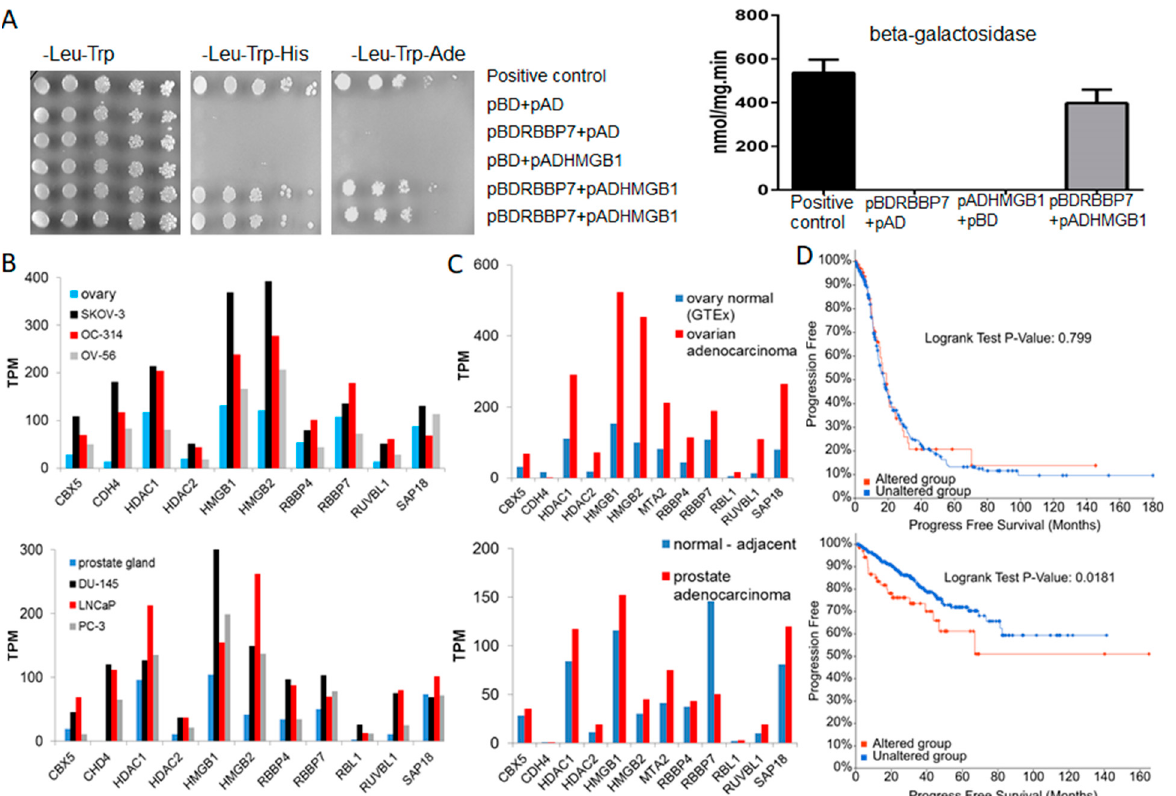
Figure 3. ( A ) Validation of the HMGB1 ‐ RBBP7 interaction by the two ‐ hybrid approach. ( B ) Differential mRNA levels of NuRD complex subunits in normal and cancerous ovary and prostate cell lines. ( C ) Differential mRNA levels of NuRD complex subunits in tumours and adjacent normal tissue in patients diagnosed of ovary and prostate cancers. ( D ) Analysis of disease ‐ free progression in patients with mRNA levels of NuRD subunits higher (altered group) or lower (unaltered group) than mean + 2SD. In ( B – D ) the upper part is from ovary cancer and lower part from prostate cancer. The source of data used in the analyses B ‐ D is detailed in the text.